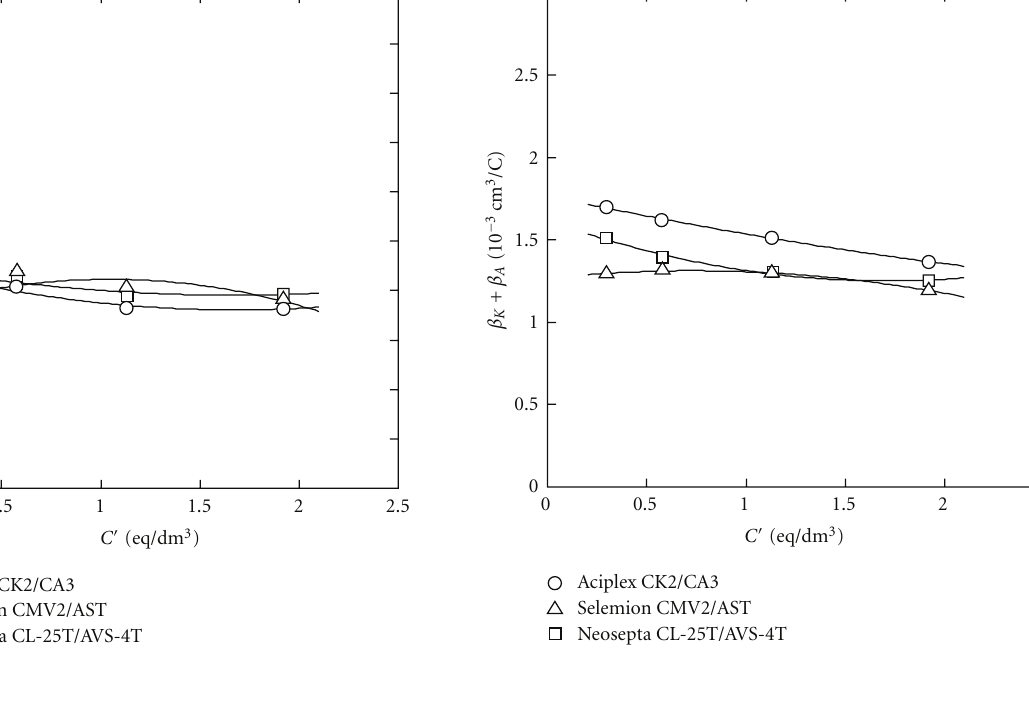
Figure 11: Relationship between salt concentration in a feeding solution and electro-osmotic permeability.